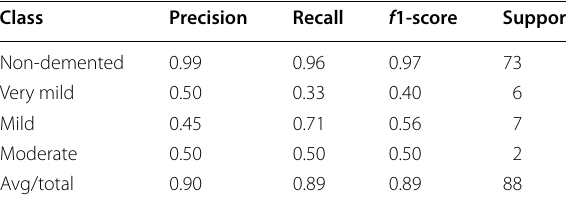
Table 3 Classification performance of M 3 model